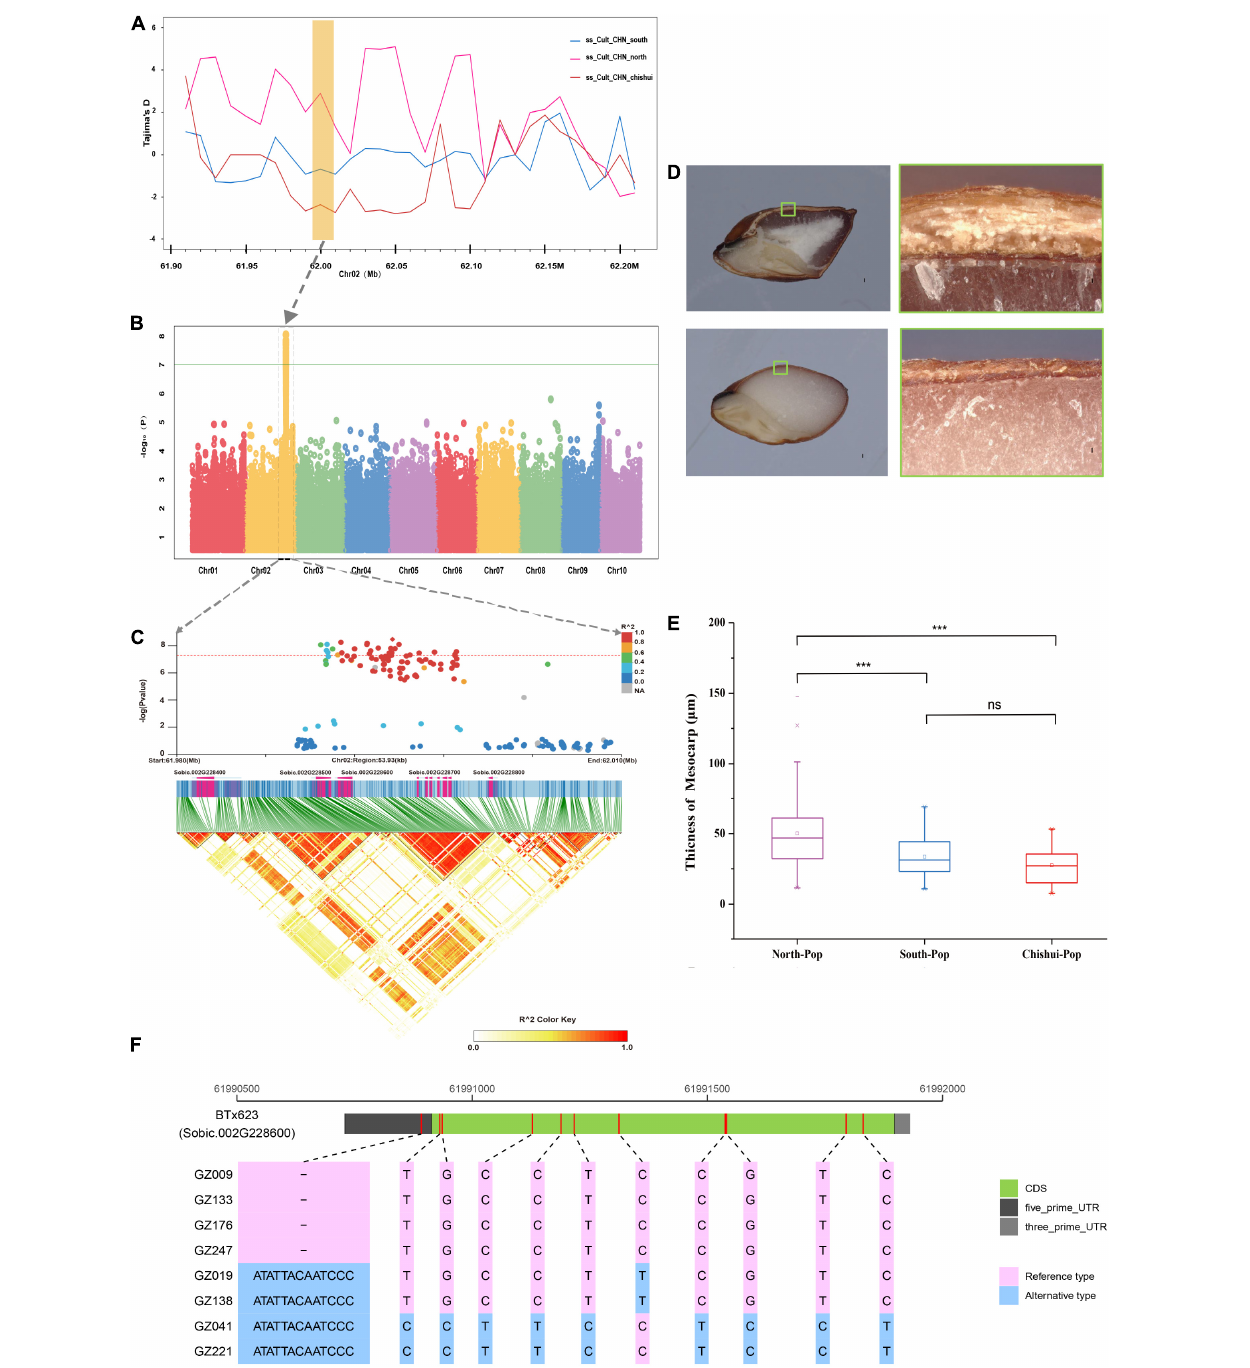
FIGURE 4 | Candidate gene for pericarp thickness based on genome-wide association study analysis. (A) The selective sweep analysis of pericarp thickness genes based on Tajima’s D values among the South population, North population and Chishui population. (B) Manhattan plots for pericarp thickness using phenotype data from the 244-accession panel in Ledong in 2020. (C) Local Manhattan plot (upper) of pericarp thickness and linkage disequilibrium (LD) heat map (lower). (D) Longitudinal sections of intact seeds from thin pericarp accession in upper right image and thick pericarp sorghum accession in lower right image. The upper and lower images on the left present close-ups of the pericarp under the microscope, respectively corresponding to the small boxes in the right images. (E) Comparisons of pericarp thickness among South population, North population, and Chishui population (*** P < 0.0001, ns indicates no significance, Student’s T -test). (F) The putative candidate gene model of pericarp thickness for eight extreme phenotypes. The red bar marks the mutant position between reference type and alternative type. INDEL in 5 (cid:48) -UTRs with pink indicates the reference genotype (thinner pericarp), while that with blue indicates the alternative genotype (thicker pericarp).